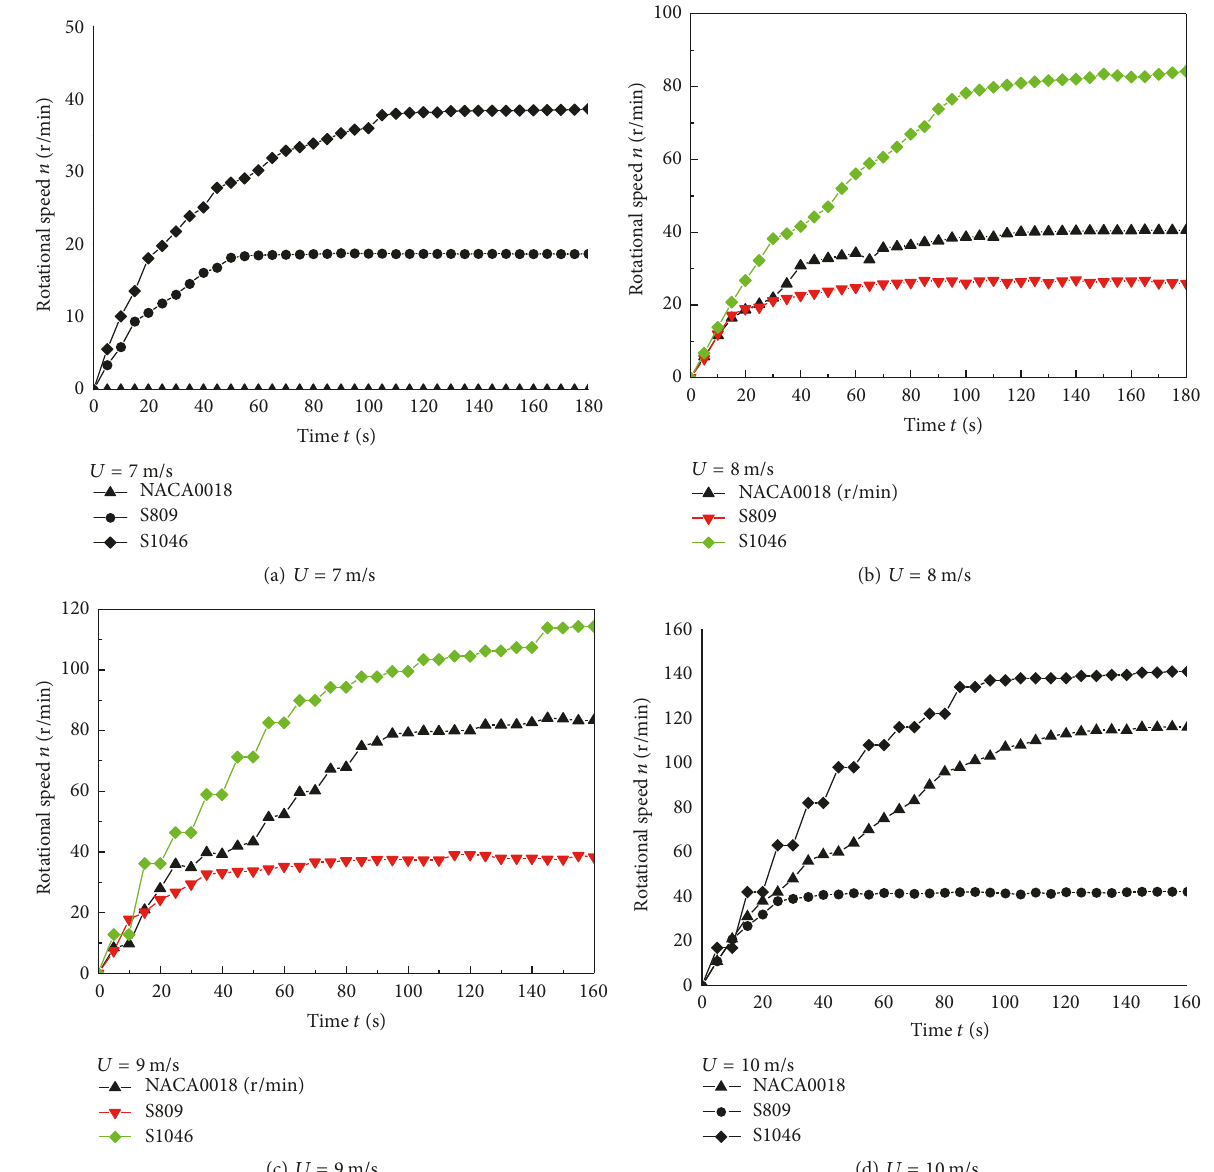
Figure 13: Rotational speed under different wind